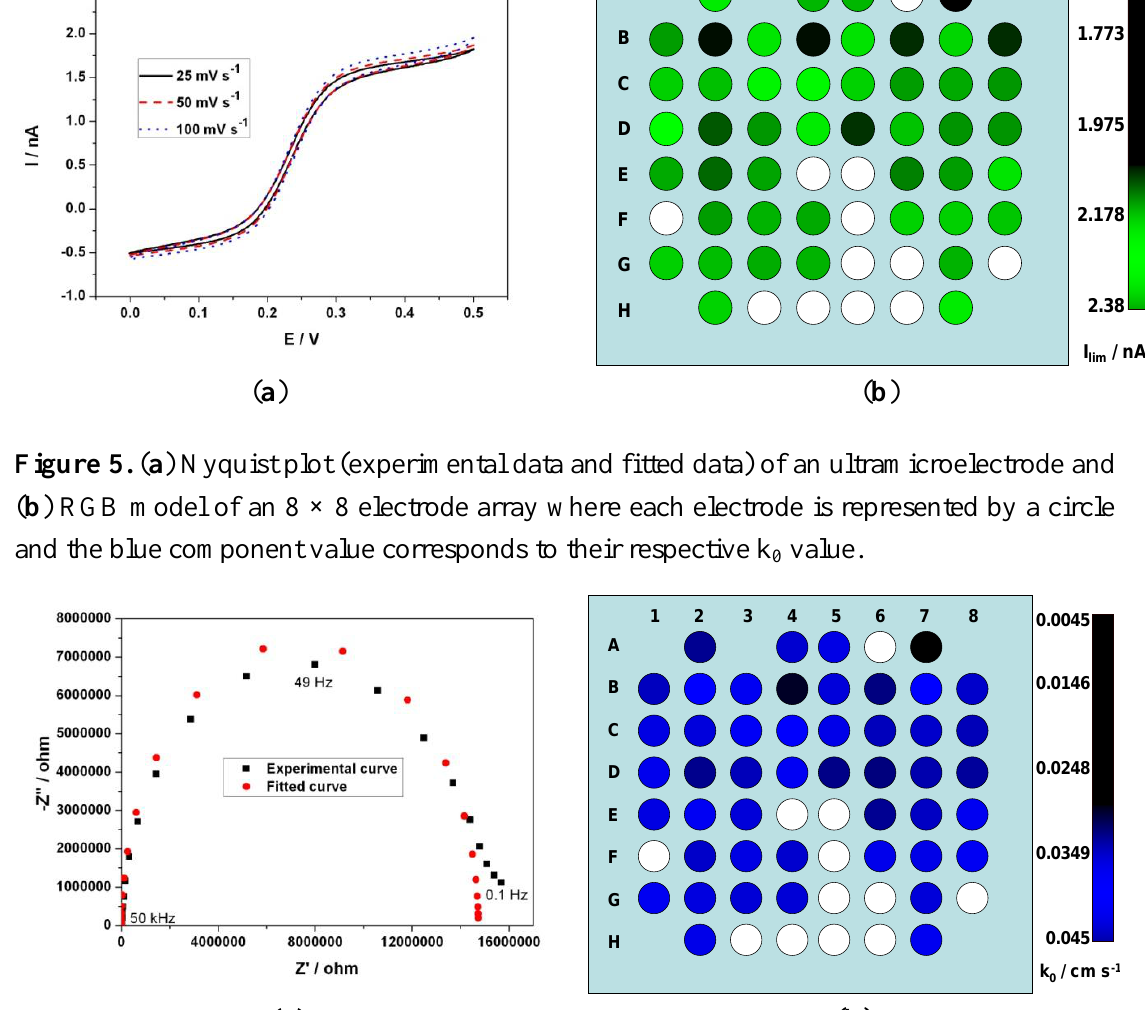
, limiting current BG